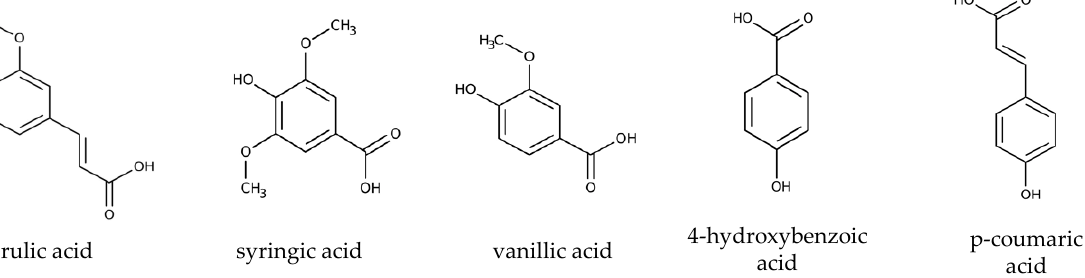
Figure 1. Chemical structure of model compounds used in the present study. Structures were created using http://www.strukturformelzeichner.de/.